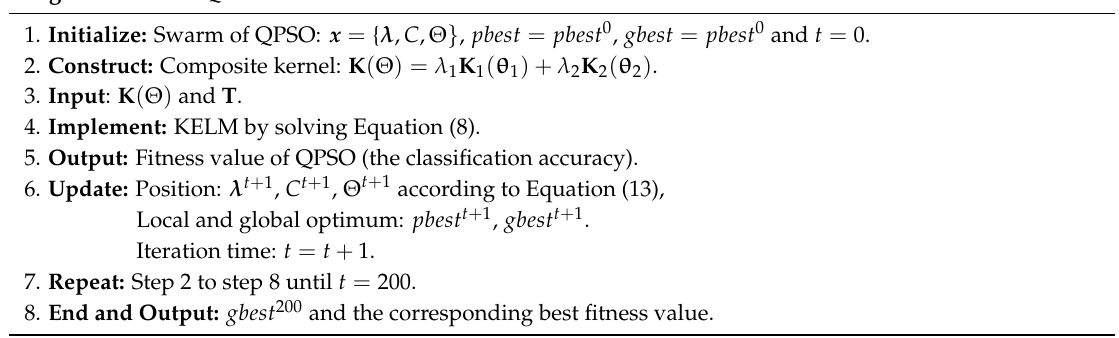
Algorithm 1. The QPSO-based WMK-ELM.